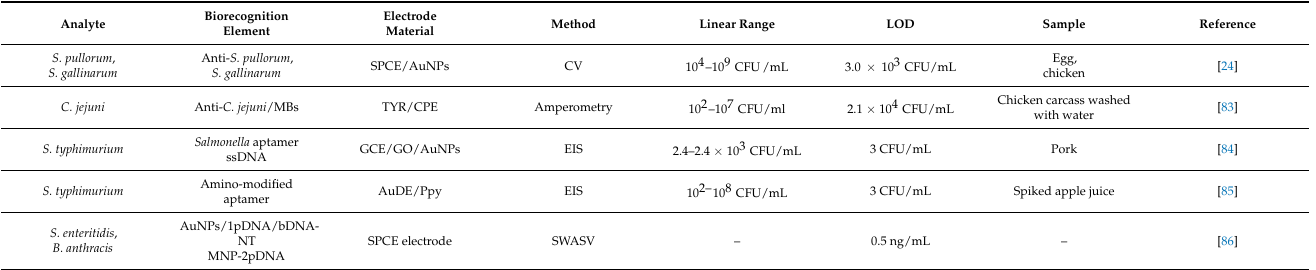
Table 3. Electrochemical sensors for different foodborne